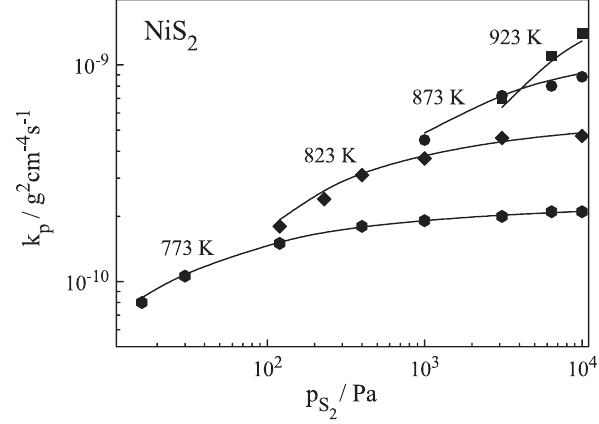
Fig. 11: The pressure dependence of the parabolic rate constant of NiS sulphidation, presented in double logarithmic plot for several temperatures.